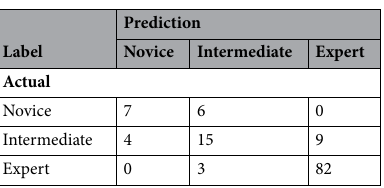
Table 2. Confusion matrix of the peg-transfer task